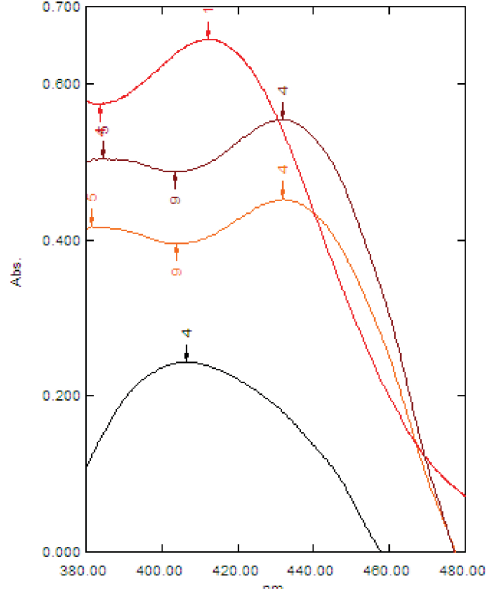
FIGURE 2 - Absorbance spectra of the silver nanoparticles formed in the presence of: 4.5 µg/mL cefadroxil ( –––– ), 5 µg/mL cefoperazone ( –––– ), 1.6 µg/mL cefotaxime ( –––– ) and 2.5 µg/mL ceftazidime ( ––––